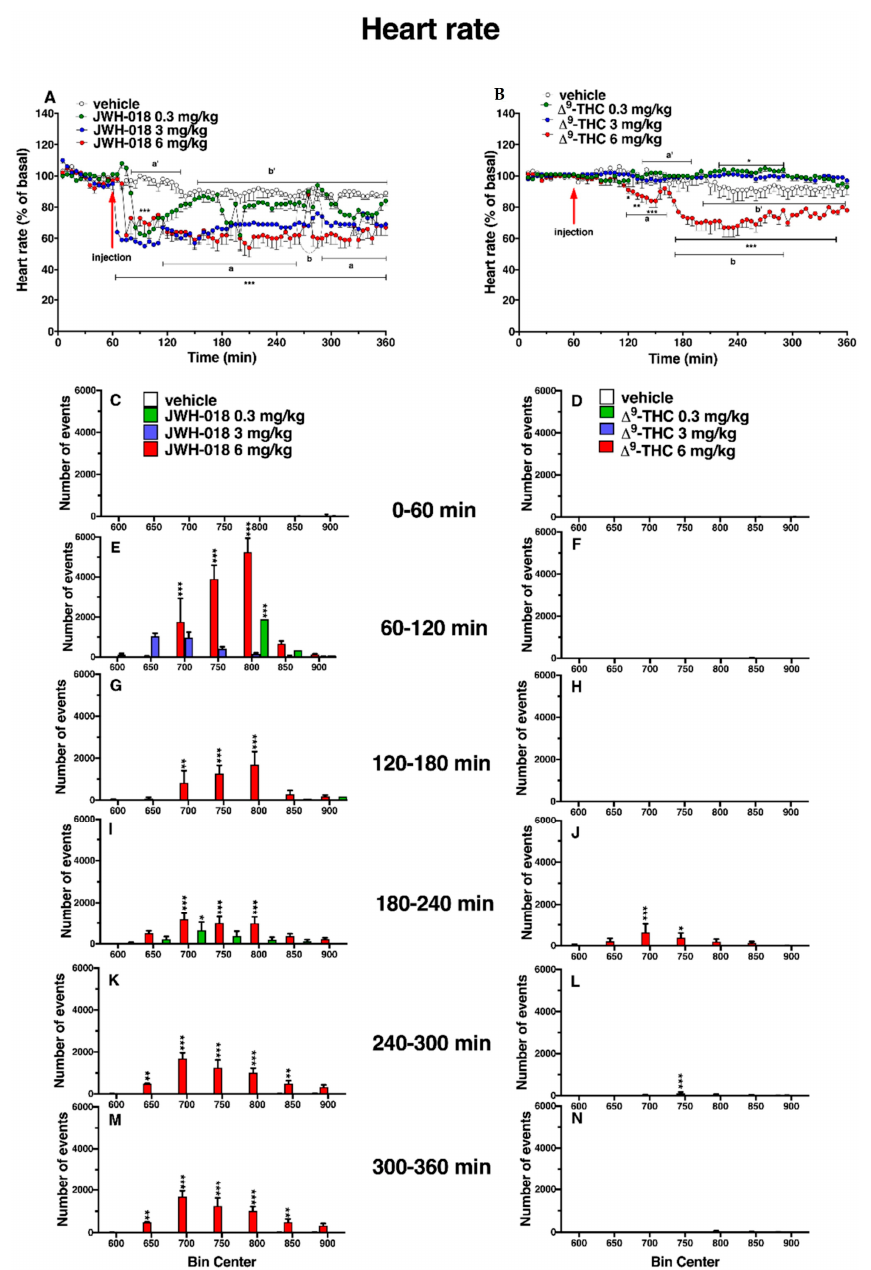
Figure 2. Effect of systemic administration of JWH-018 (0.3–6 mg/kg, panel ( A ), and ∆ 9 -THC (0.3–6 mg/kg, panel ( B )) on heart rate. Data are expressed as percentage of basal values in the form MEAN ± SEM of 6 different evaluations for JWH-018 experiments and MEAN ± SEM of 8 different evaluations for ∆ 9 -THC experiments. Statistical analysis was performed by two-way ANOVA, followed by Bonferroni’s test for multiple comparisons. * p < 0.05 ** p < 0.01 *** p < 0.001 versus vehicle. Vehicle and 6 mg/kg dose curves are marked by letters (a’, b’ for vehicle and a, b 6 mg/kg treatment) to compare effects with ECG electrical parameters (Table 1). Frequency of tachyarrhythmia episodes after administration of JWH-018 (0.3–6 mg/kg, panels ( C , E , G , I , K , M ) and ∆ 9 -THC (0.3–6 mg/kg, panels ( D , F , H , J , L , N ), expressed as number of events per mean heart rate value in the form MEAN ± SEM of 6 different evaluations for JWH-018 experiments and MEAN ± SEM of 8 different evaluations for ∆ 9 -THC experiments. Statistical analysis was performed by two-way ANOVA, followed by Bonferroni’s test for multiple comparisons. * p < 0.05 ** p < 0.01 *** p < 0.001 versus